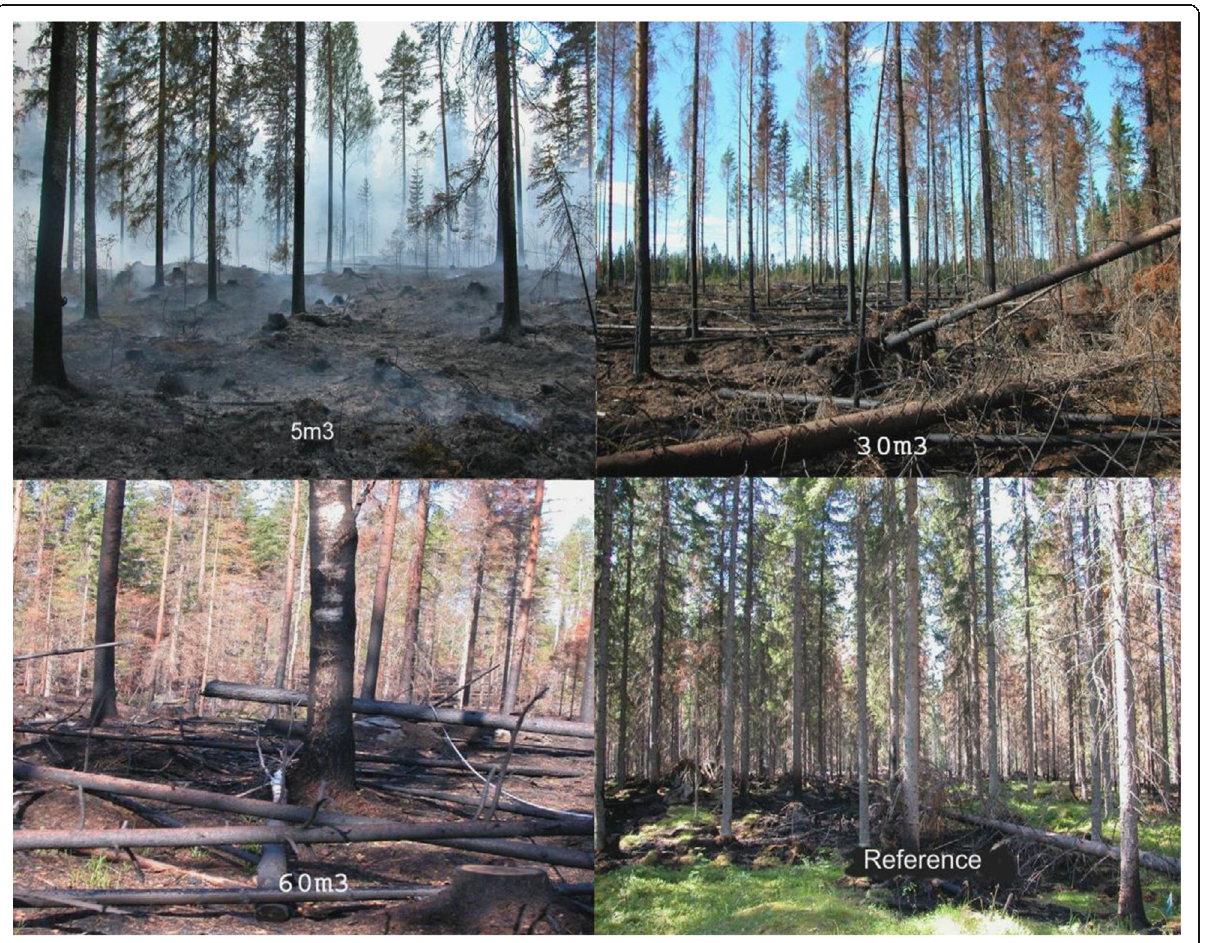
Fig. 2 Experimental burning treatments in Norway spruce-dominated stands with a standing retention of 50 m 3 /ha and three different levels of down wood retention (5, 30, and 60 m 3 /ha) and uncut reference in the Evo area, southern Finland, 2002. From Vanha-Majamaa et al. (2007), photos Erkki Oksanen/Natural Resources Institute